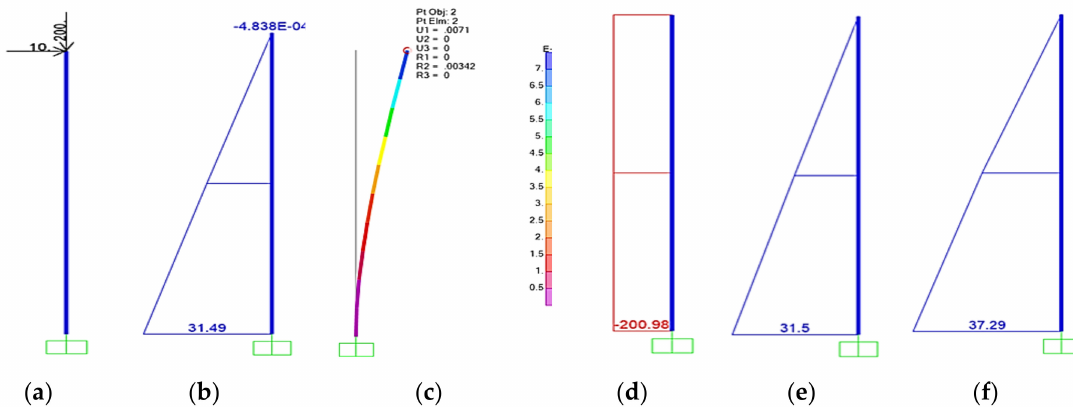
Figure 4. Illustration of the q factor in P - ∆ e ff ect in a cantilever: ( a ) applied loads; ( b ) moment diagram with P - ∆ e ff ect; ( c ) deformed configuration due to lateral loads; ( d ) axial load in the element; ( e ) moment diagram with implicit P - ∆ e ff ect in the sti ff ness matrix; ( f ) moment diagram with implicit P - ∆ e ff ect in the sti ff ness matrix considering the amplification from the behavior